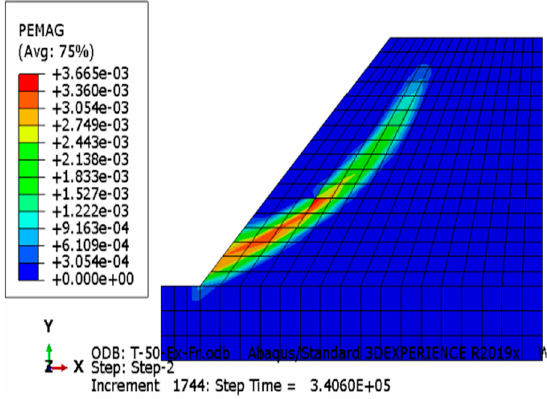
Figure 8. Cloud map of equivalent plastic zone of instability of cutting slope after 50 freeze–thaw cycles .